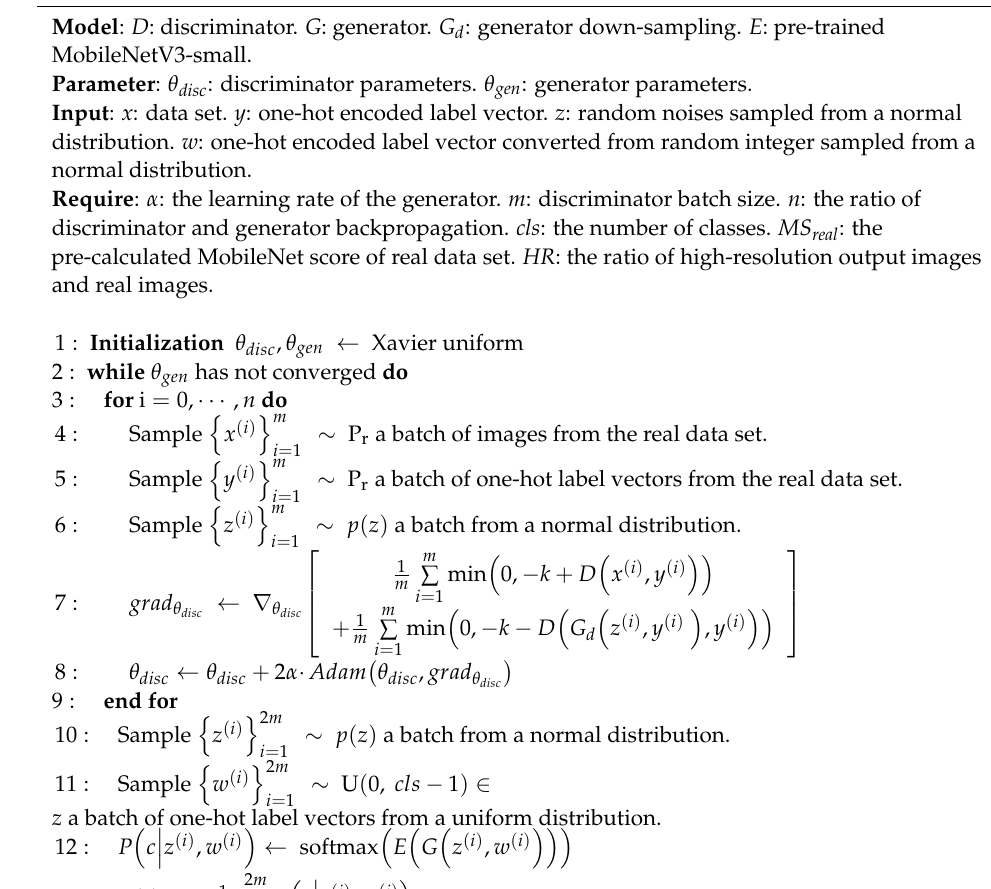
Algorithm 1 HRGAN training